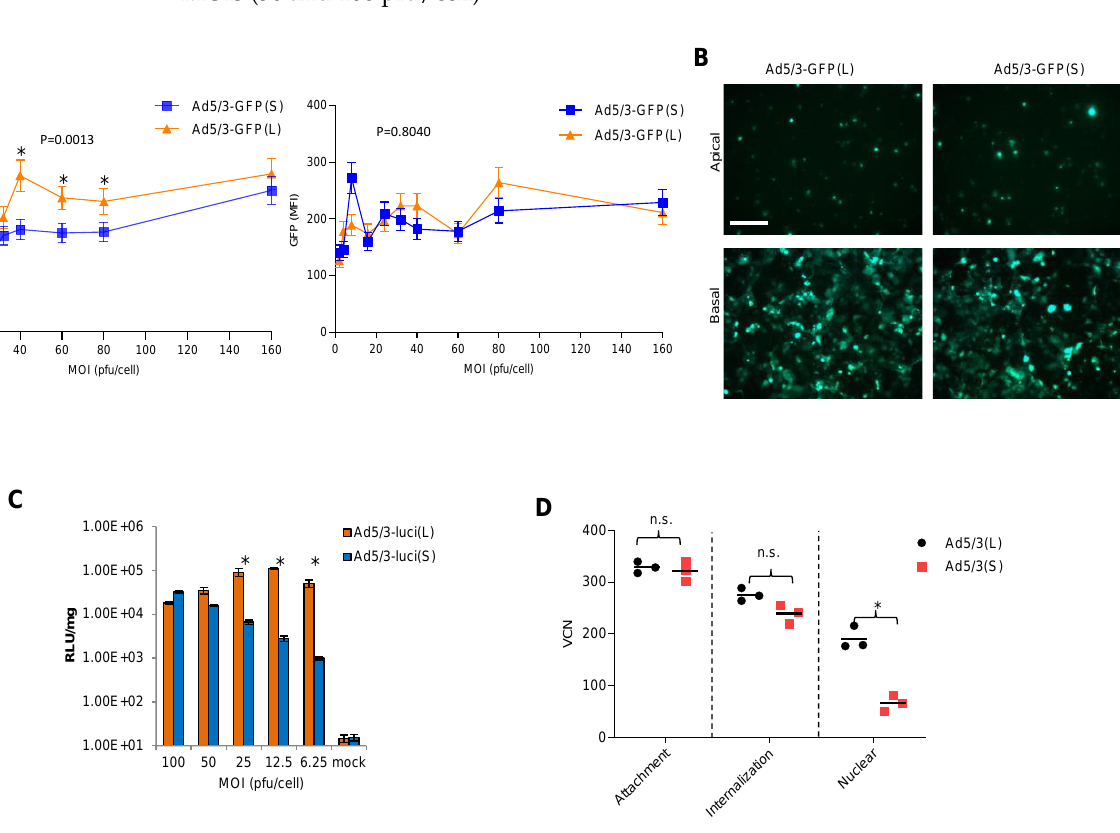
Figure 3. In vitro transduction studies. ( A ) T84 cells were infected with Ad5/3-GFP viruses at the indicated MOIs. GFP expression was analyzed 20 h after infection by flow cytometry. The left panel shows the percentage of GFP-positive cells; the right panel shows the mean GFP fluorescence inten- sity (MFI). n = 3. * p <0.05. ( B ) To form tight junctions between T84 cells, 2 × 10 5 T84 cells were plated into polyester membrane transwell inserts and cultured for 21 days with medium change every 3 days. Ad5/3-GFP(S) and Ad5/3-GFP(L) (MOI 200 pfu/cell) were used to infect cells from the apical